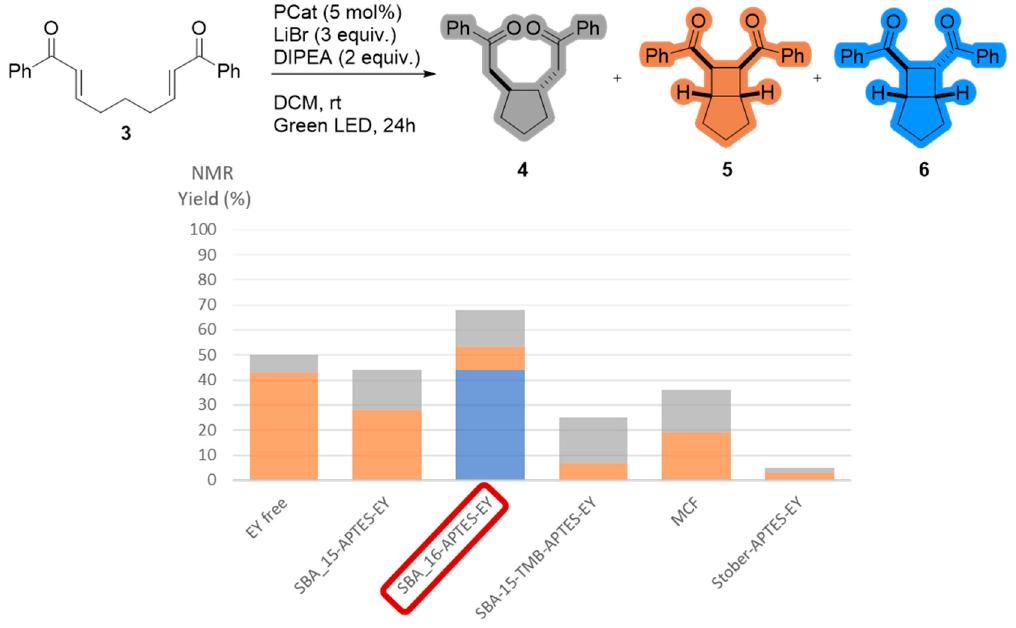
Molecules 2023 , 27 , x FOR PEER REVIEW Figure 3. Influence of porous material on photoreductive cyclization of 3 in presence of LiBr.